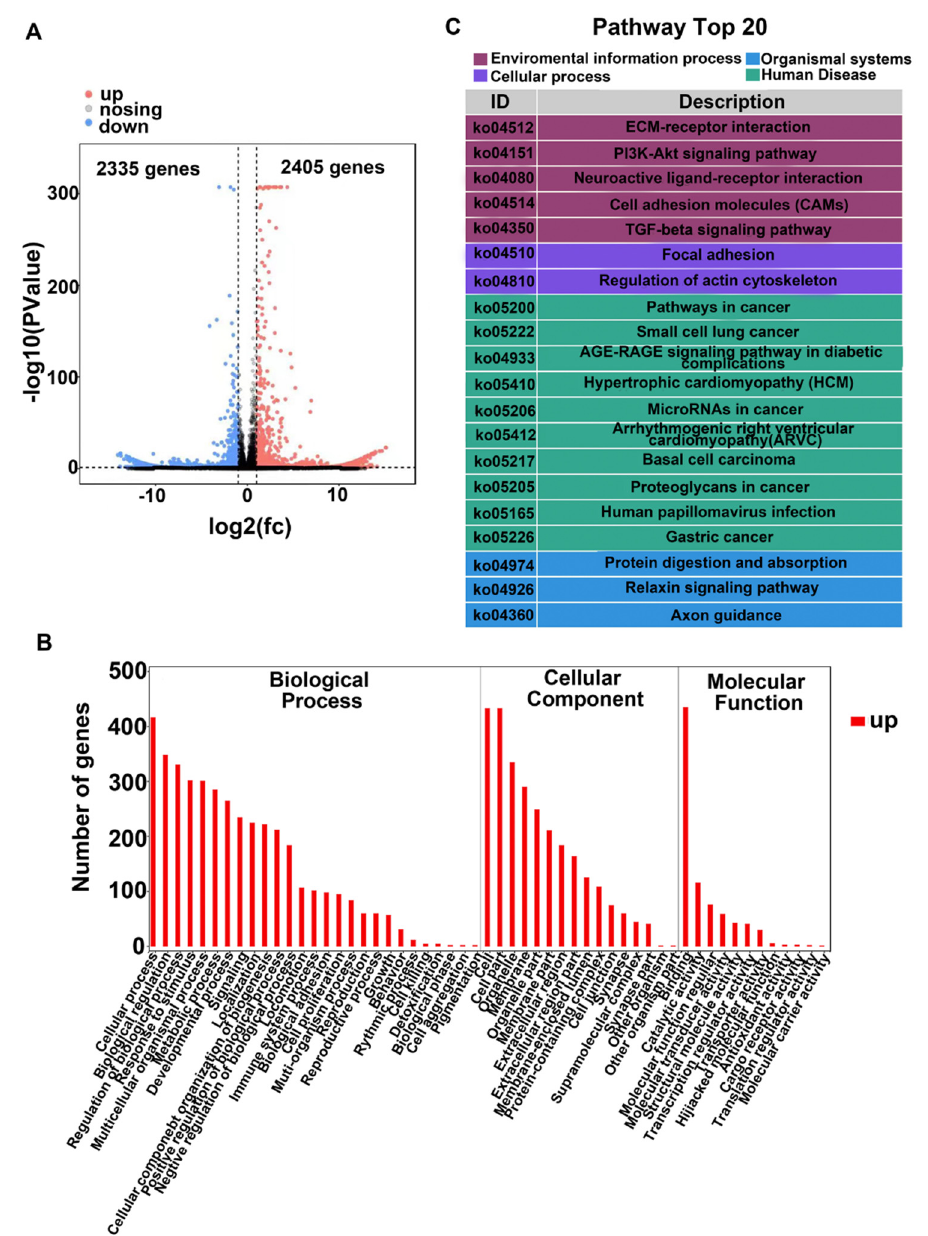
Figure 1. RNA sequencing analysis of TGF- β 2-induced major changes in human RPE cells. ( A ). Number of significantly altered genes in TGF- β 2-treated ARPE-19 cells. Volcano plot: X -axis: indication of the protein difference multiple (take log2); Y -axis: corresponding − log10 ( p value). Red points: significantly up-regulated proteins; green points: significantly down-regulated proteins; gray points: proteins without significant changes. Untreated cells were used as controls. ( B ). GO analysis of biological processes, cellular components and molecular functions of genes altered by TGF- β 2 treatment. ( C ). KEGG enrichment of signaling pathways in TGF- β 2-treated cells. Top 20 of up-regulated pathways.